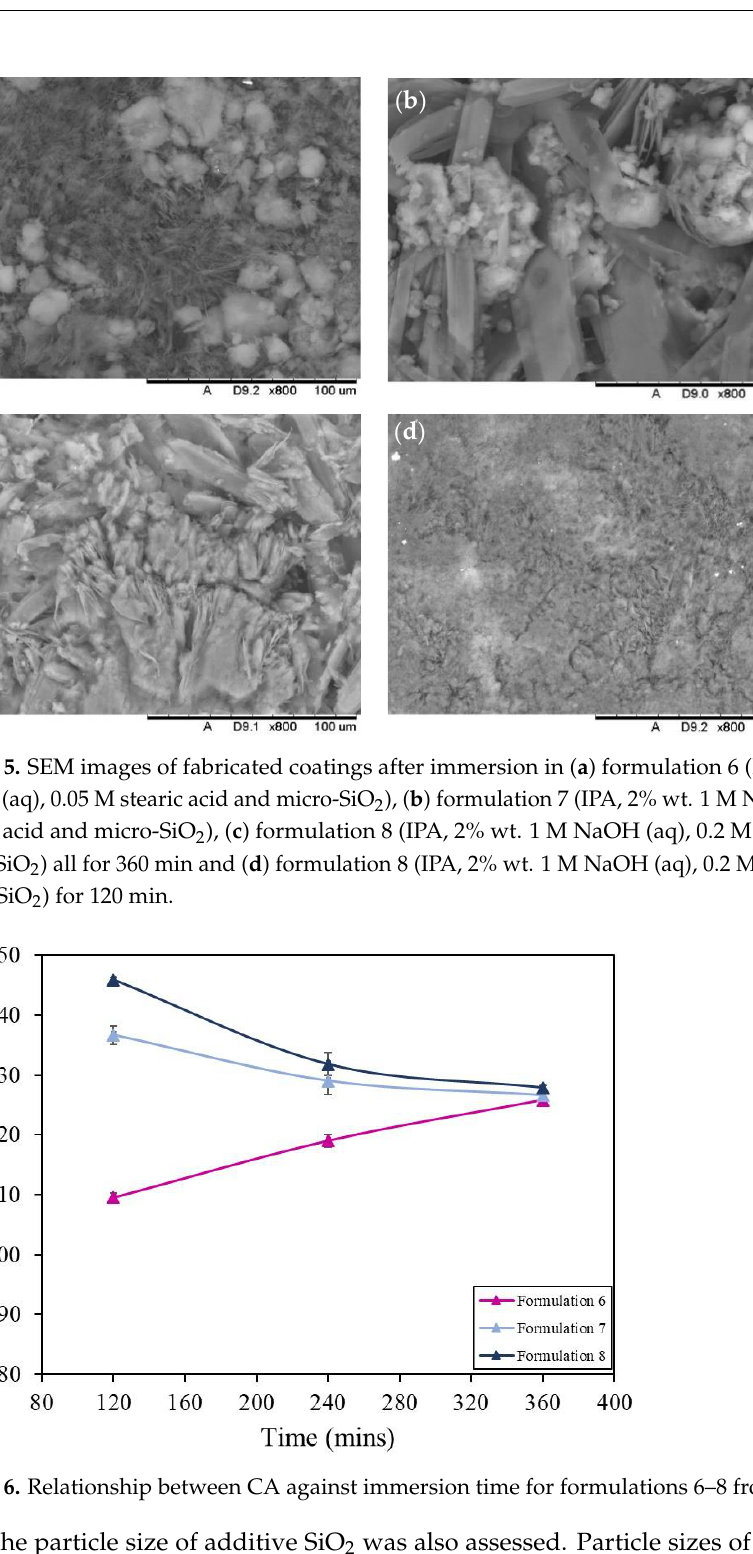
Figure 6. Relationship between CA against immersion time for formulations 6–8 from Table 1.